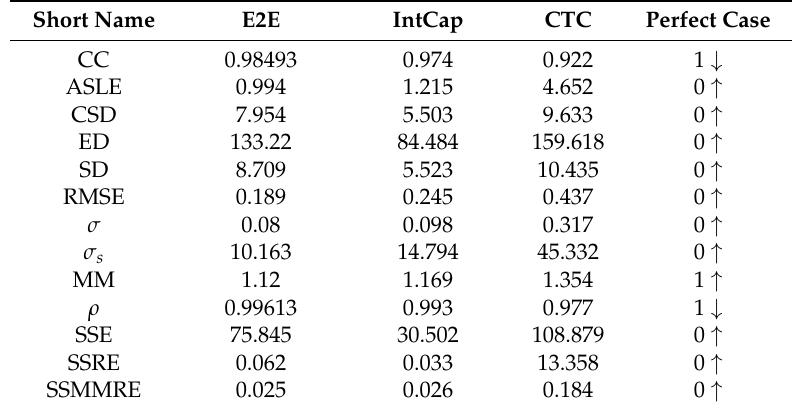
Table 5. Numerical indices results for OLTC influence (frequency range 20 kHz–256